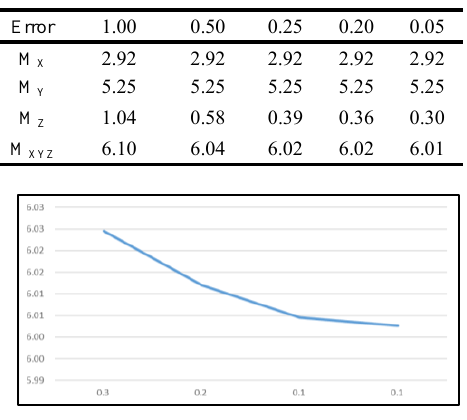
Figure 5. Influence of platform position error